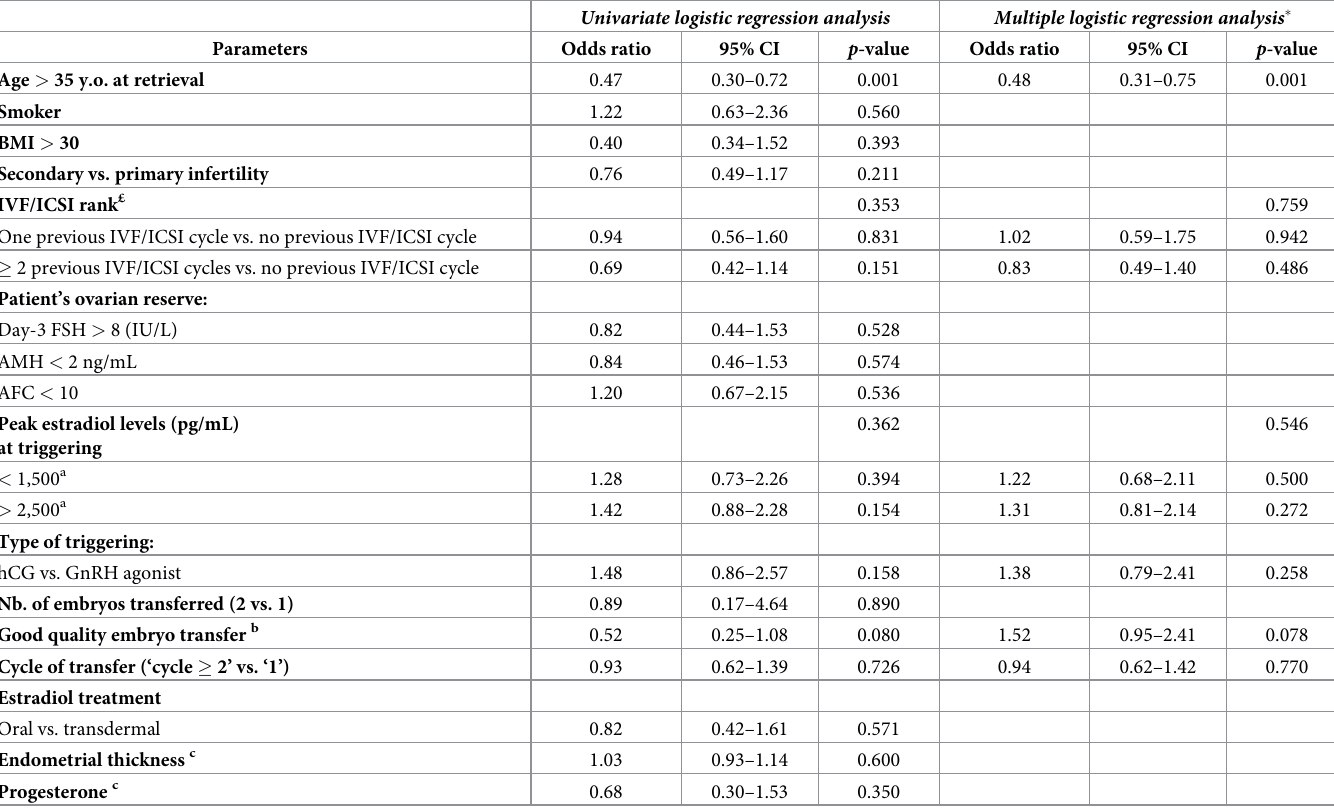
Table 3. Factors affecting the live birth rate after frozen-thawed blastocyst transfer: Logistic regression analysis of the